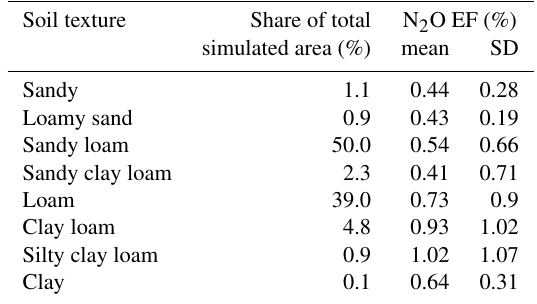
Table 4. Estimated N 2 O EF by type of soil texture. Soil textures are listed in order of decreasing hydraulic conductivity.